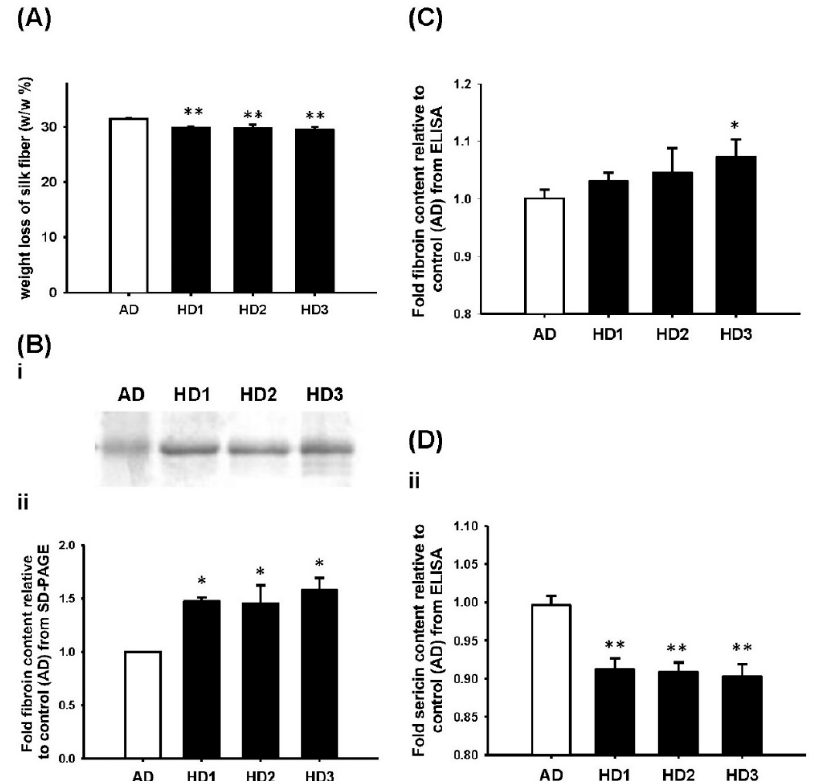
Figure 1. Comparison of silk fibroin purified from alkaline degumming (AD) and heat degumming for 1, 2, and 3 h (HD1, HD2, and HD3). ( A ) The weight loss of silk fibers after different treatments. ( B ) SDS-PAGE analysis of the fibroin (i) and fold content relative to control (AD) (ii) in SF prepared by HD1–3 procedures. ELISA analysis of the fold fibroin ( C ) and sericin ( D ) relative to control (AD) in SF prepared by HD1–3 procedures. Statistically significant differences between AD and HD were determined by Dunnett’s multiple comparison post hoc test. * p < 0.05 and ** p < 0.01; n = 4; all error bars represent the standard error of the mean.